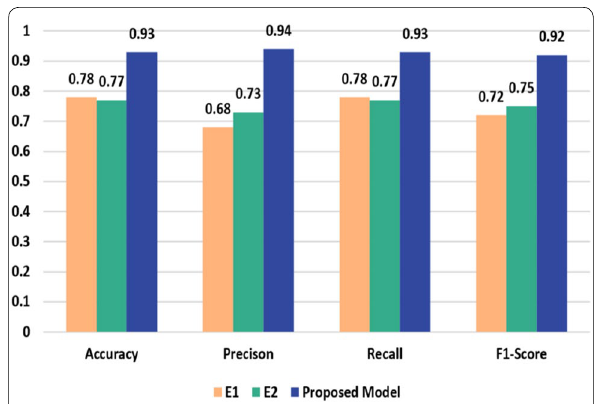
Fig. 8 Performance comparison of the proposed model and the variants